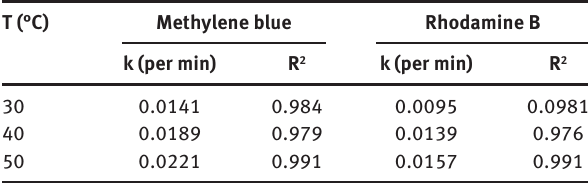
Table 1: Rate constants of Ag-TiO Methylene blue and Rhodamine B dye at various temperatures.